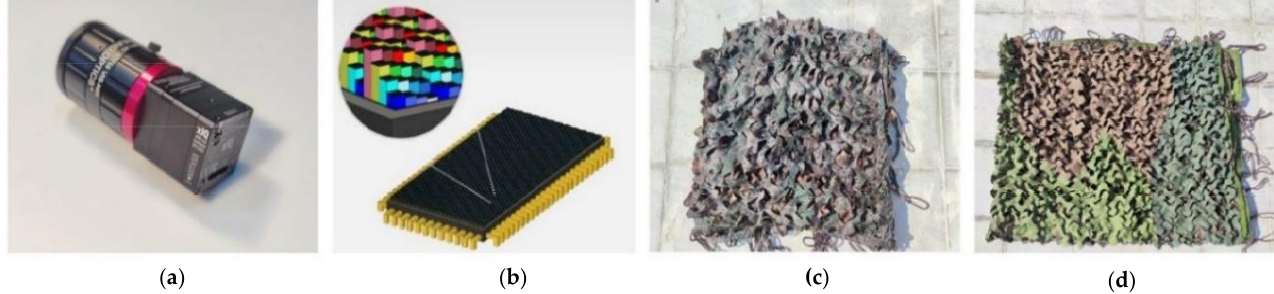
Figure 2. ( a ) The XIMEA camera; ( b ) The diagram of a 5 × 5 Filter array on the imaging sensor; ( c ) The ASRC-net; ( d ) The AIRC-net.